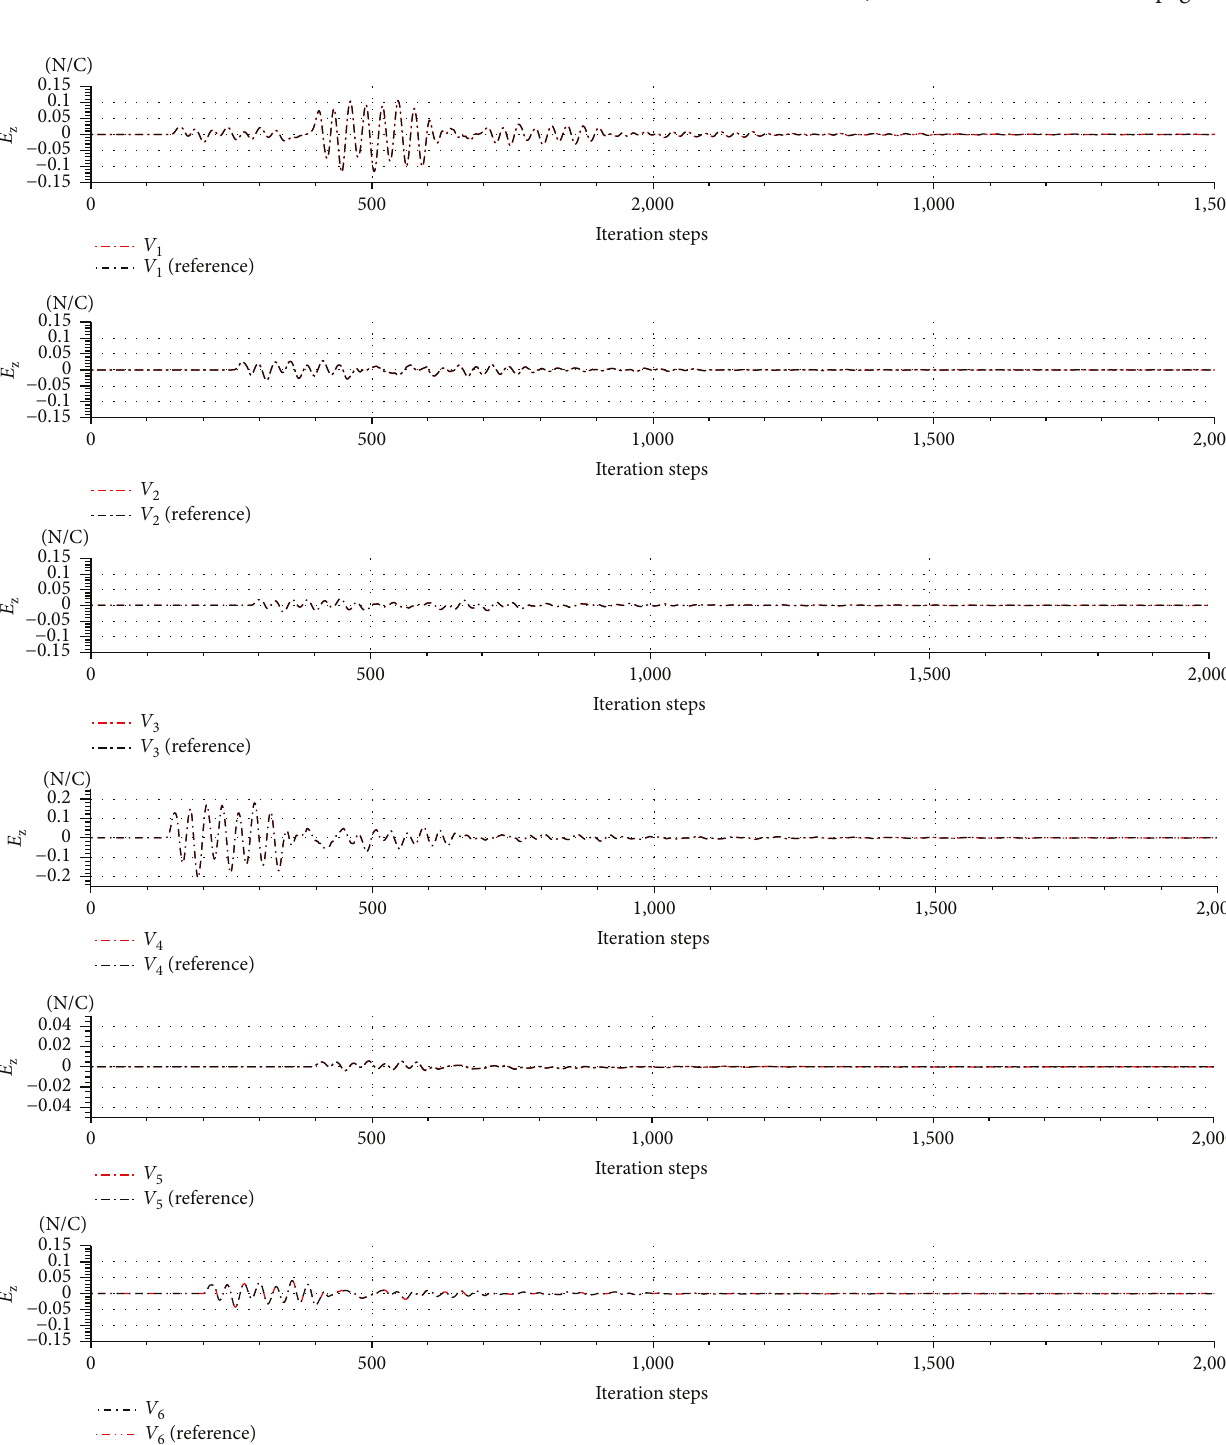
of side 6 × 10 − 05 m, while the size of the plates is of 4 15 × 10 − 05 m long by 7 50 × 10 − 06 m width. The separation between the plates is 9 375 − 06 m. The orange dots represent sources and are located at a distance of 2 537 × 10 − 05 from